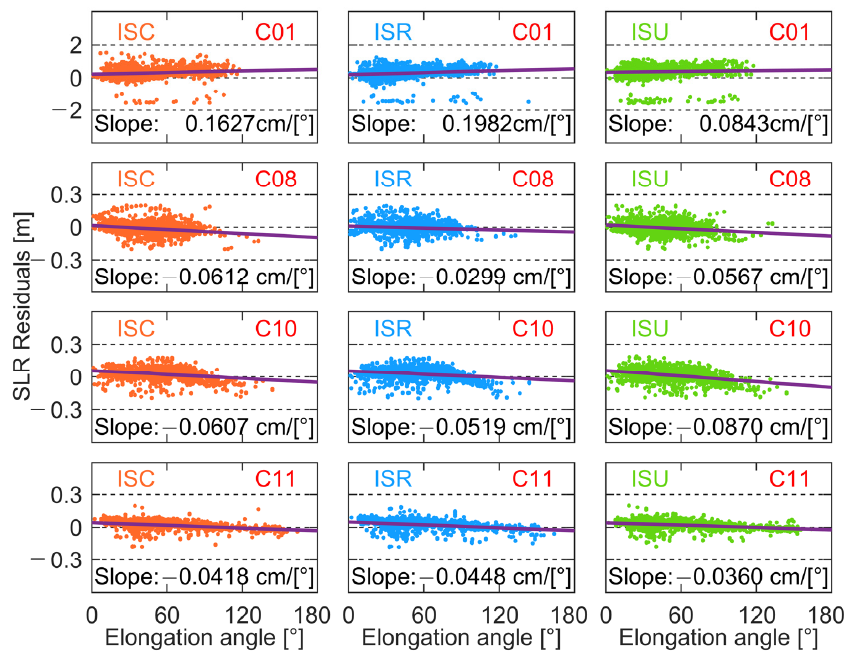
Figure 18. SLR residuals of BDS-2 satellites based on three types of iGMAS B1I/B3I orbits versus elongation angle.